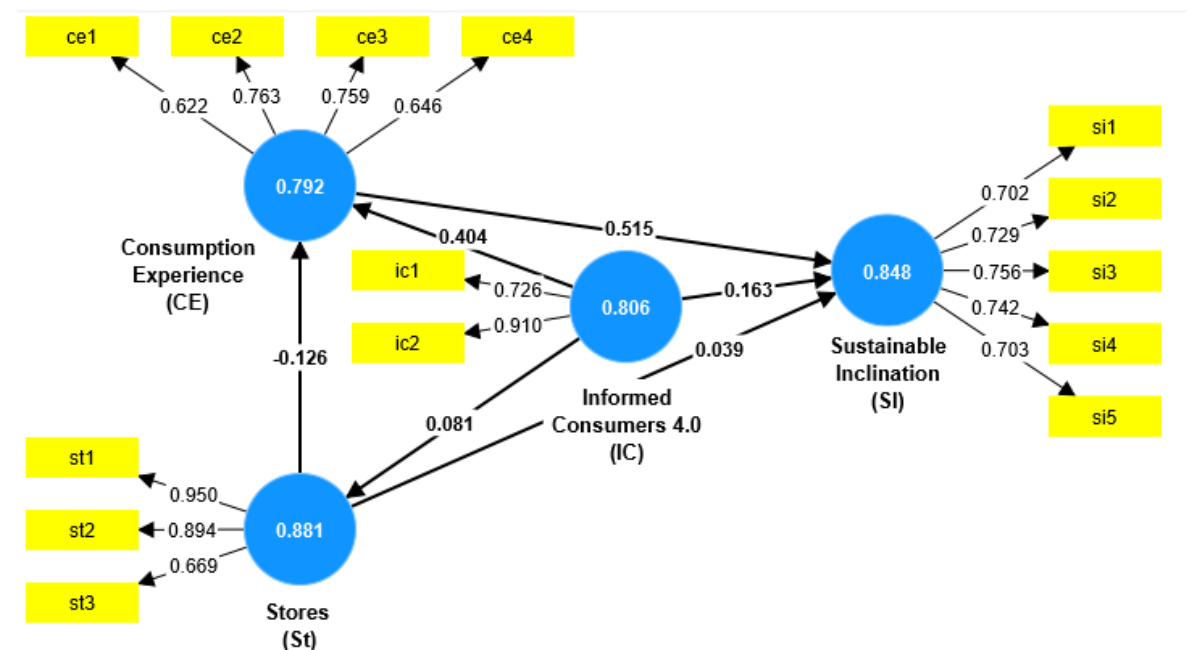
Figure 2. SEM (PLS algorithm). The values in the constructs are Composite Reliability (CR) Source: Authors elaboration from data analysis in Smart-PLS3. Table 4. Standardized factor loading Composite Reliability (CR) Average Variance Extracted (AVE) and Cronbach’s Alpha.